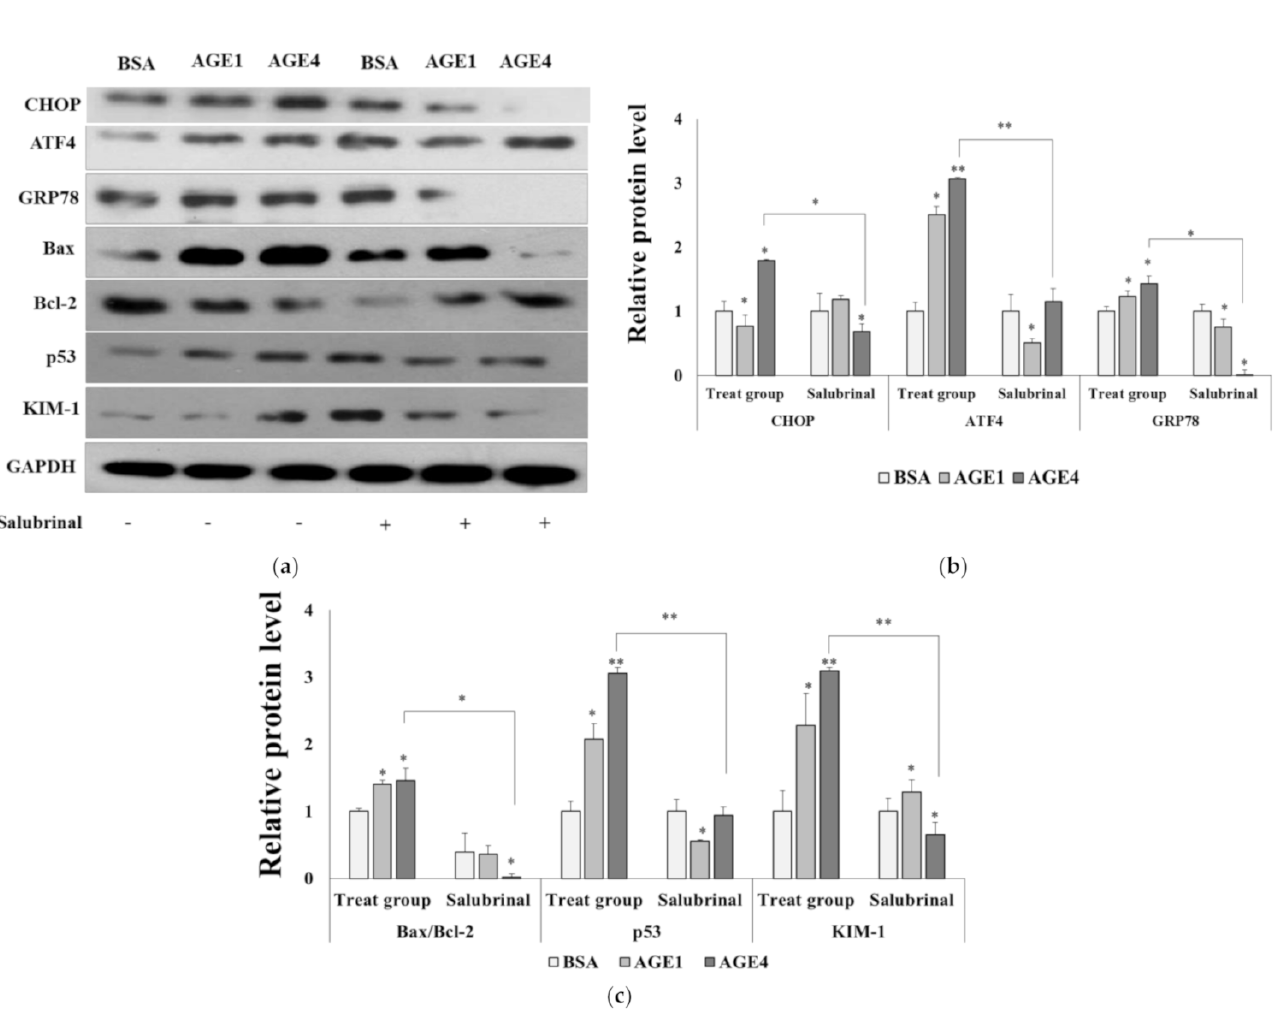
Figure 4. Effects of AGE4 on the ER stress and apoptosis in HK-2 cells. ( a ) After pretreatment with 10 µ M, salubrinal and AGE4 (200 µ g/mL, 24 h), the protein expression levels of CHOP, ATF4, GRP78, Bax, Bcl2, p53, and KIM-1 were determined by Western blotting. ( b , c ) Densitometric analysis was performed using ImageJ, and the ratio of the expression of the target protein to that of GAPDH was calculated. Plus sign represents the presence of salubrinal. Minus sign represents the absence of salubrinal. Data are expressed as the mean ± standard deviation (SD) of at least three independent experiments. The groups were compared using a Student’s t -test, and the levels of statistical significance are indicated as follows: * p < 0.05, and ** p <